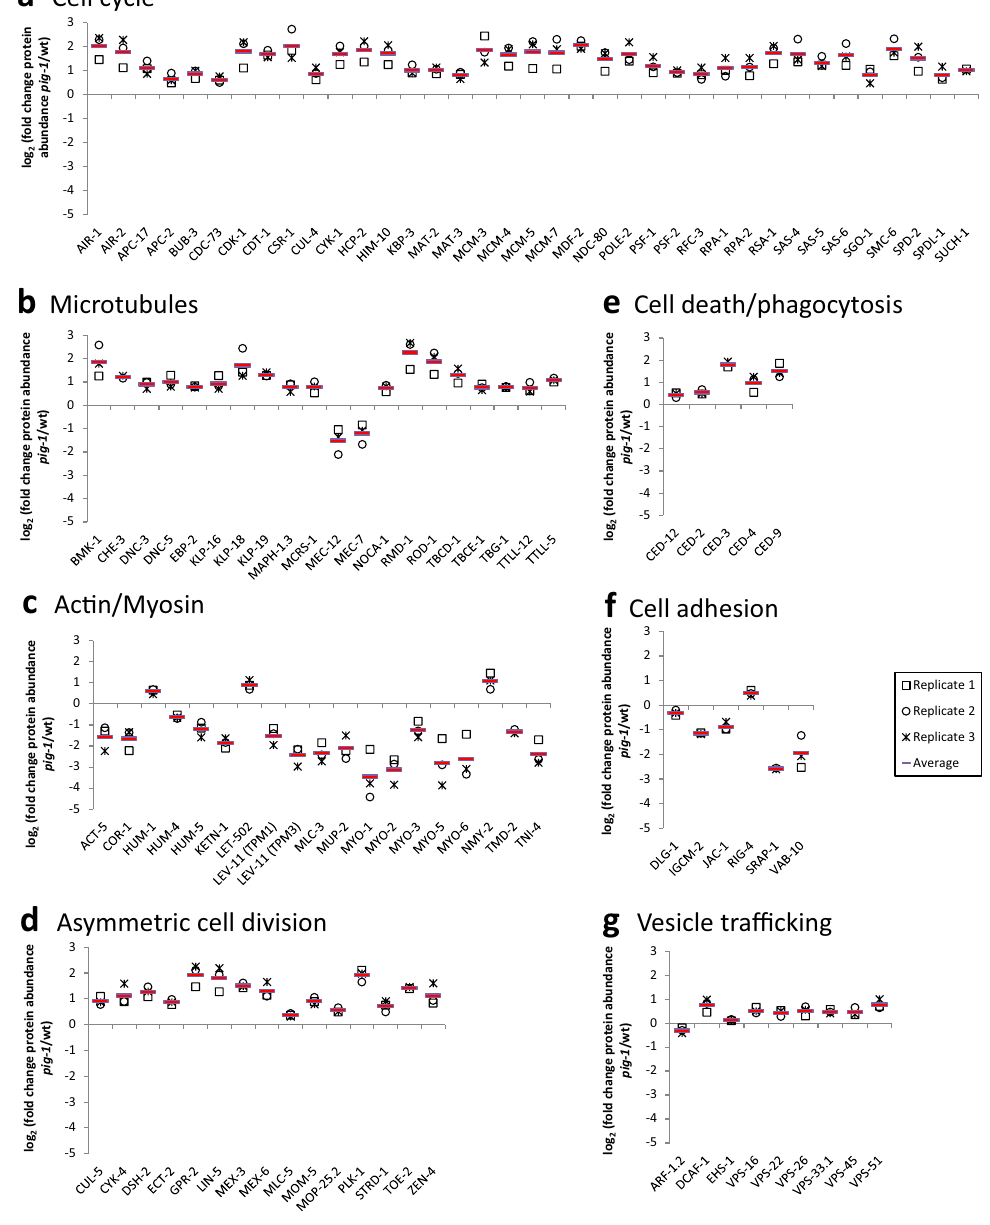
Figure 5. Abundance changes of key pathway proteins in pig - 1 mutant embryos. Proteins exhibiting a significantly different abundance (in log 2 scale) in pig - 1 mutant embryos as compared to wild-type embryos, in at least two out of the three biological replicates (p-value < 0.05, two-tailed t-test; FDR < 5%) (replicate values are indicated in black and the calculated average over the replicates is indicated in red). Proteins are grouped according to their functional association with. ( a ) cell cycle regulation, ( b ) microtubule regulation, ( c ) actomyosin regulation, ( d ) asymmetric cell division, ( e ) cell death or phagocytosis, ( f ) cell adhesion, or ( g ) vesicle